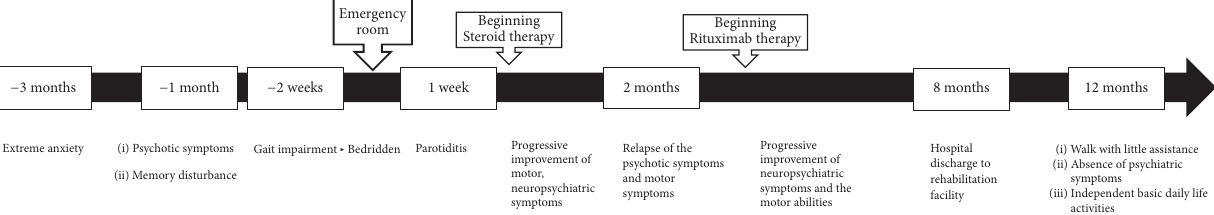
Figure 4: Diagram representing the timeline of the relevant clinical events. The time on the arrow refers to the date of emergency room